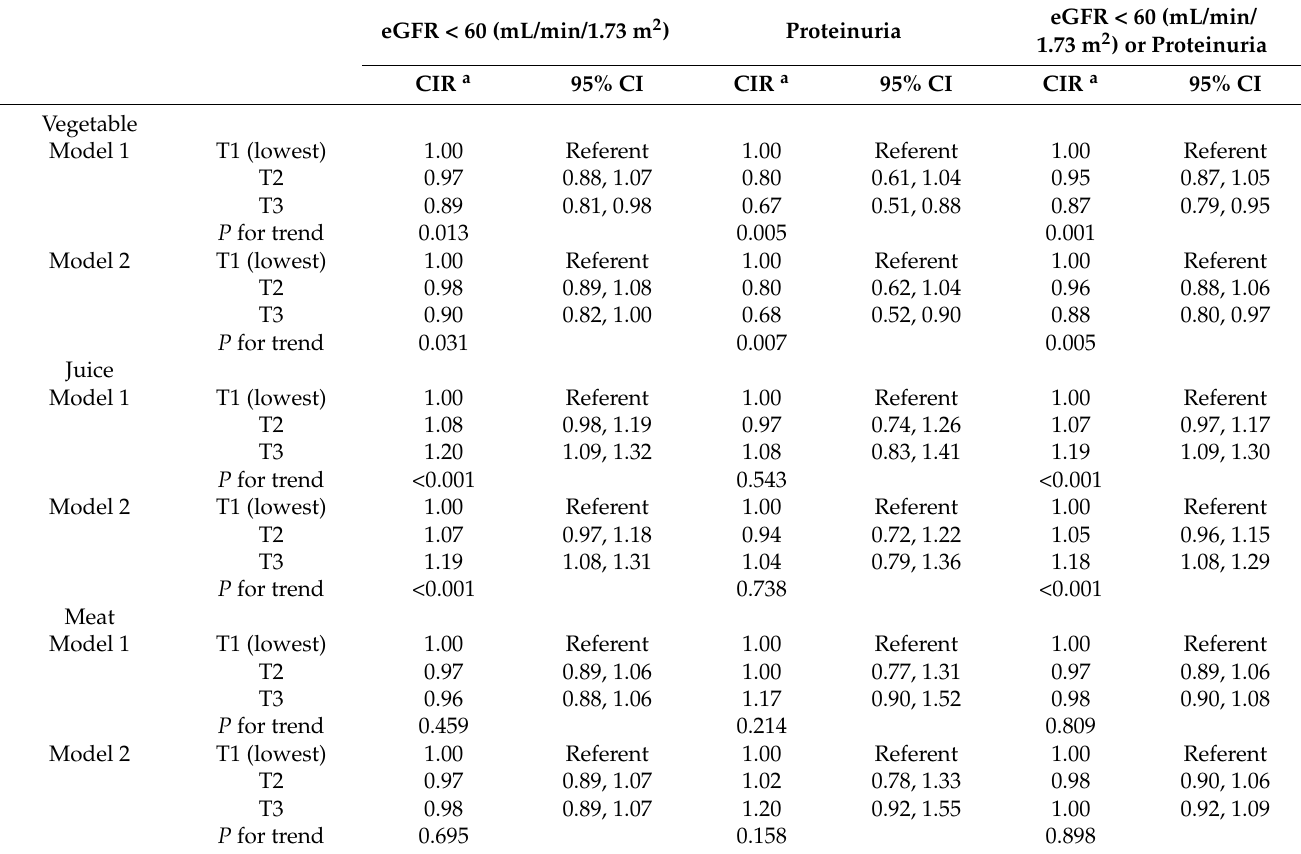
Table 4. Cumulative incidence ratios (95% confidence intervals) of impaired kidney function among dietary patterns, 2012–2015,